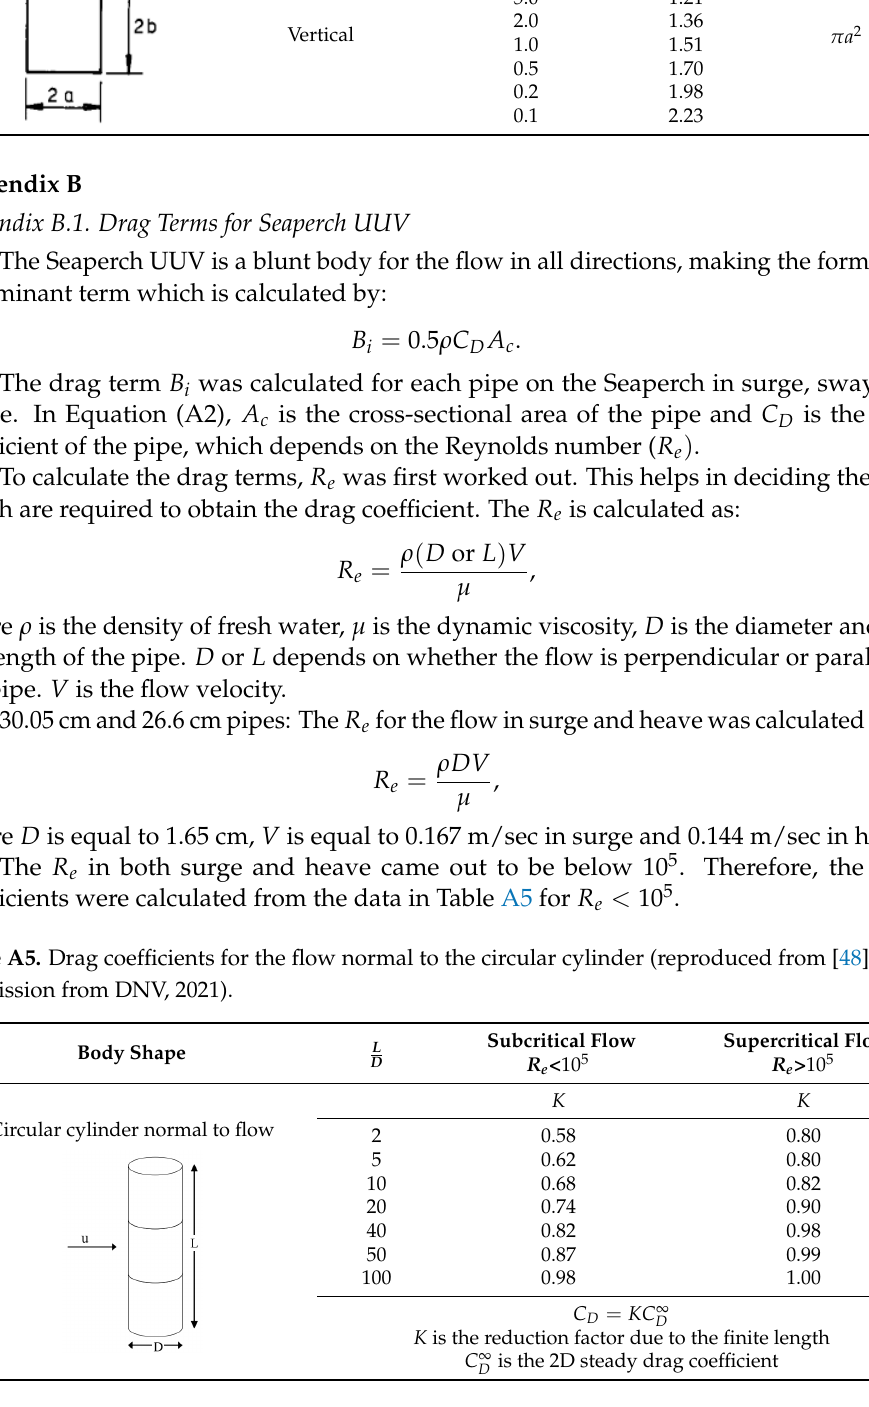
Table A6. Drag coefficients for the flow normal to the infinitely long ellipse (reproduced from [48], with permission from DNV,